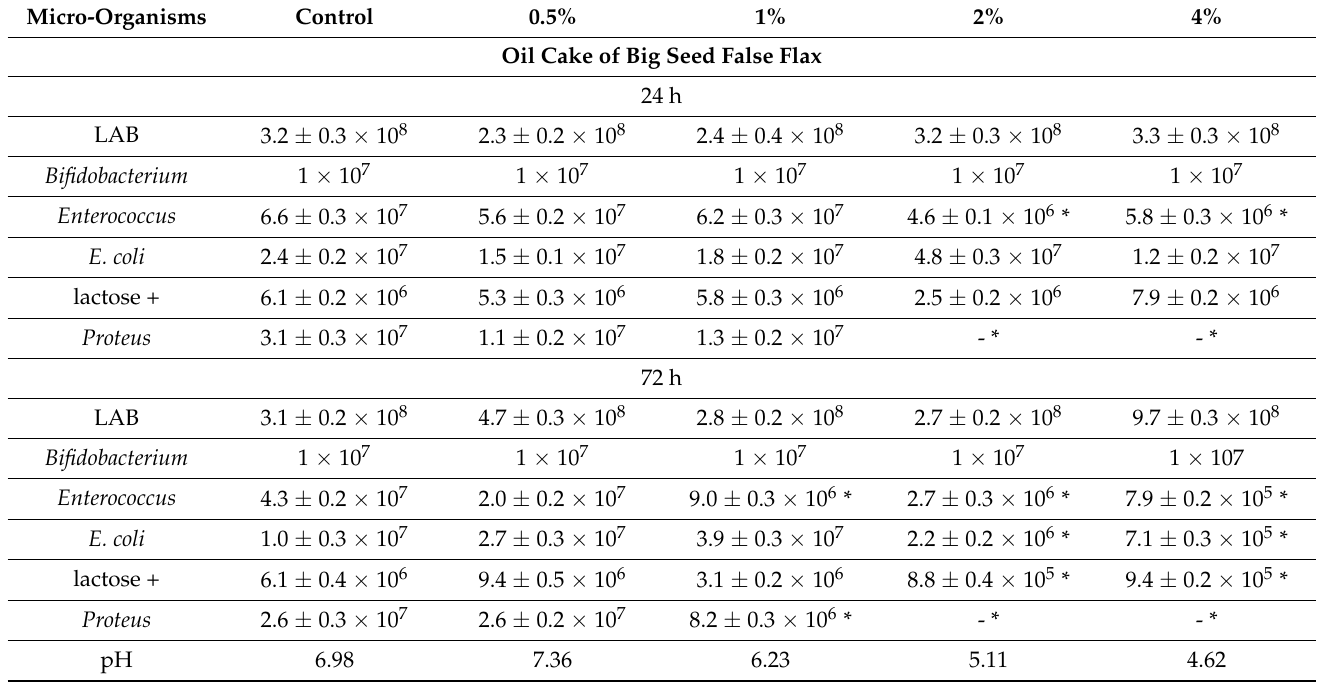
Table 2. Influence of cakes of essential oil plants on the number of intestinal micro-organisms of chickens,